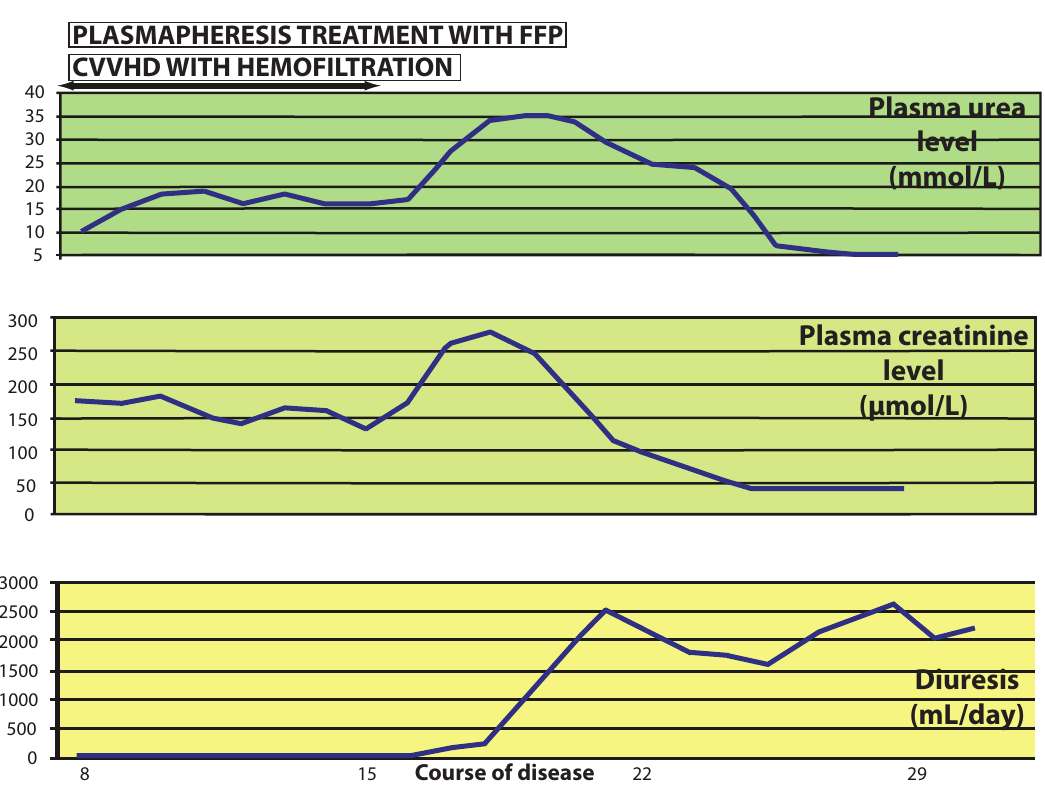
Figure 1. Gradual recovery of renal function. Plasma creatinine and urea levels and urine output during the disease course and applied treatment show significant improvement of renal function by the end of CVVHD and plasmapheresis and normal function is restored in the 4th week of disease without the evidence of permanent